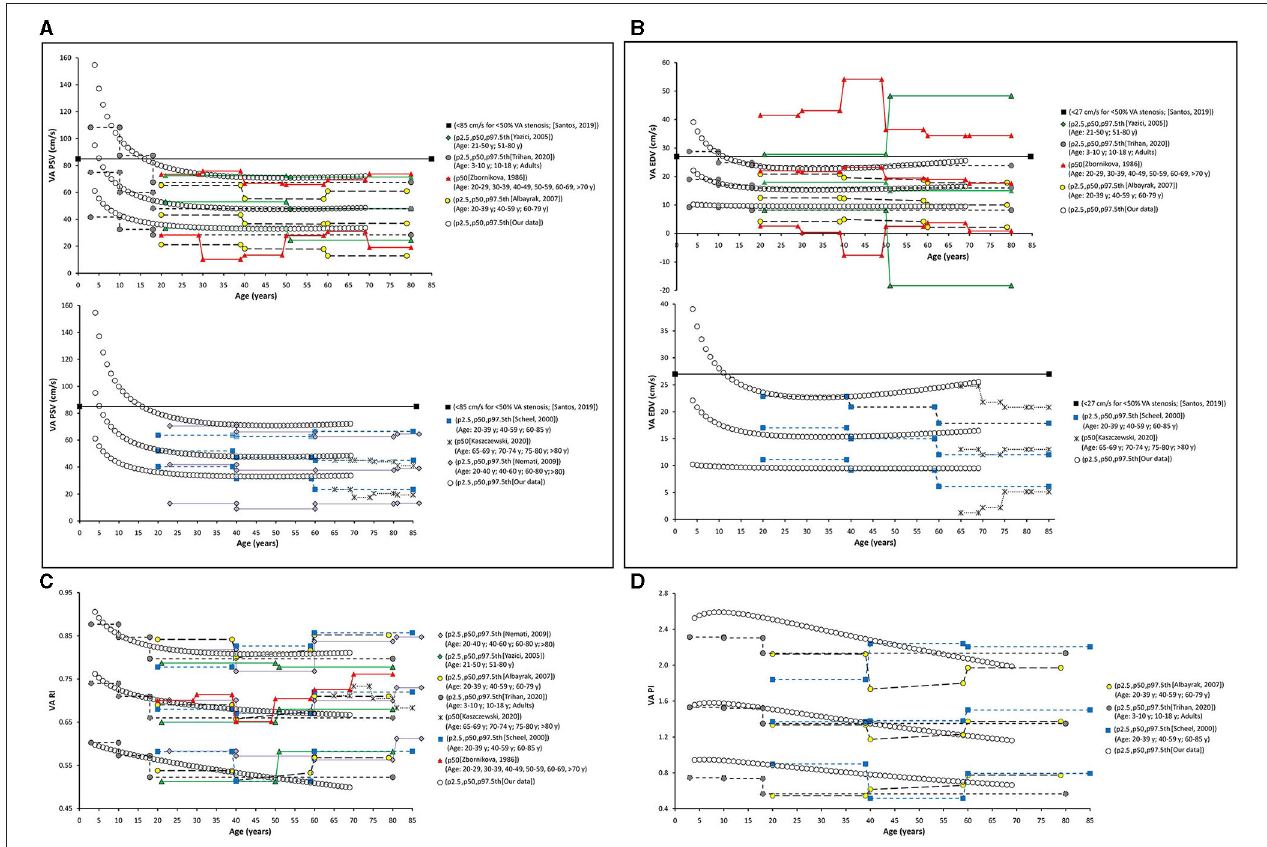
FIGURE 10 | Vertebral artery. Comparison among curves of PSV (A) , EDV (B) , RI (C) , and PI (D) , obtained in our study (2.5th, 50th and p97.5th percentiles) and mean values (p50th), and 2.5th (MV − 1.96 × SD) and 97.5 (MV + 1.96 × SD) percentiles obtained by other authors when studying groups of subjects of different ages. The fixed cut-off levels used to identify (graduate) levels of arterial stenosis are also shown.